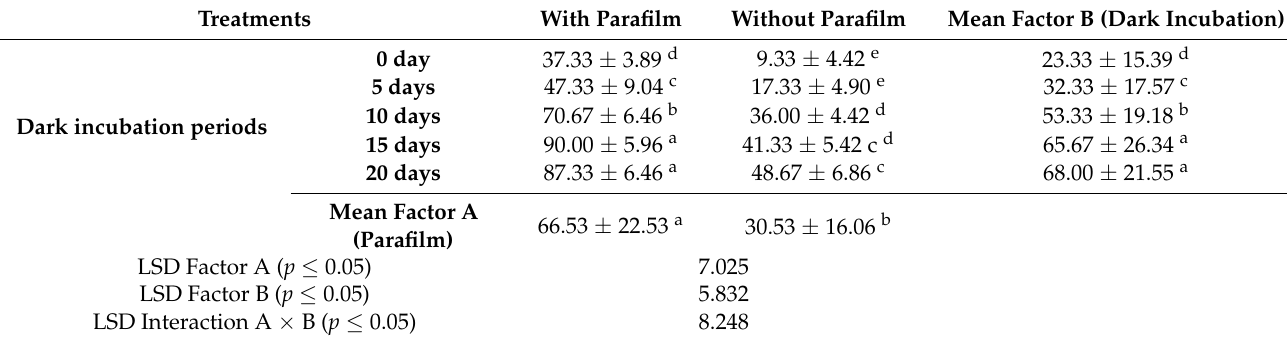
Table 1. Effect of dark incubation periods, Parafilm wrapping, and the interaction on shoot regeneration. Decapitated seedlings wrapped with or without Parafilm were kept in the dark for 0, 5, 10, 15, and 20 days prior to culture under natural light conditions for another 2 weeks. Treatments With Parafilm Without Parafilm Mean Factor B (Dark Incubation)